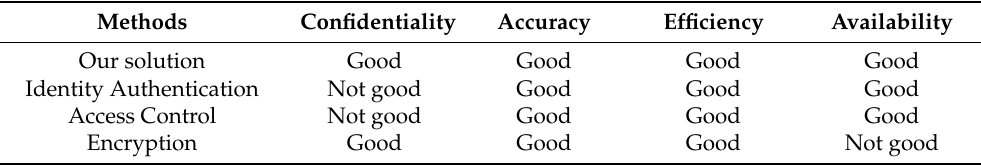
Table 1. A comparison between our solution and other related ones.